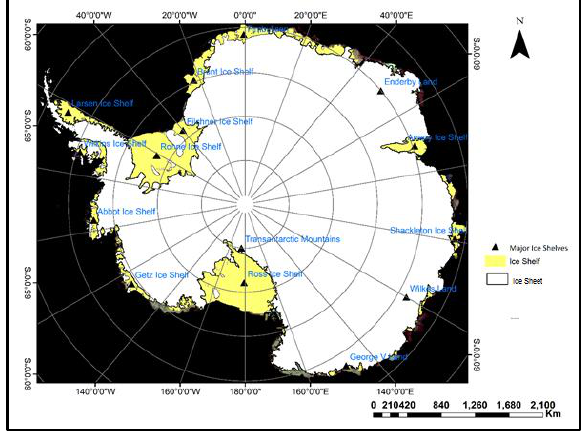
Figure 1. Location of study area